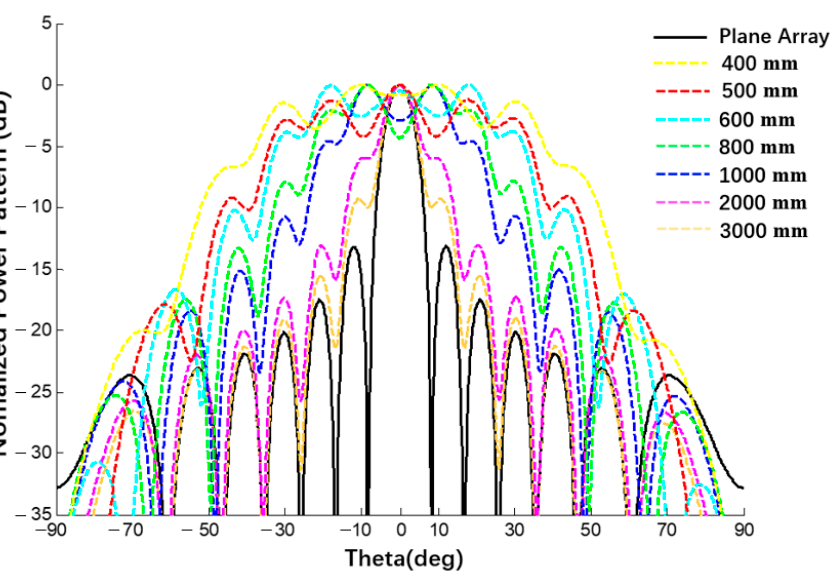
Figure 23. Comparison of the influence of different radii on the pattern when calculated using MATLAB (uniform excitation).